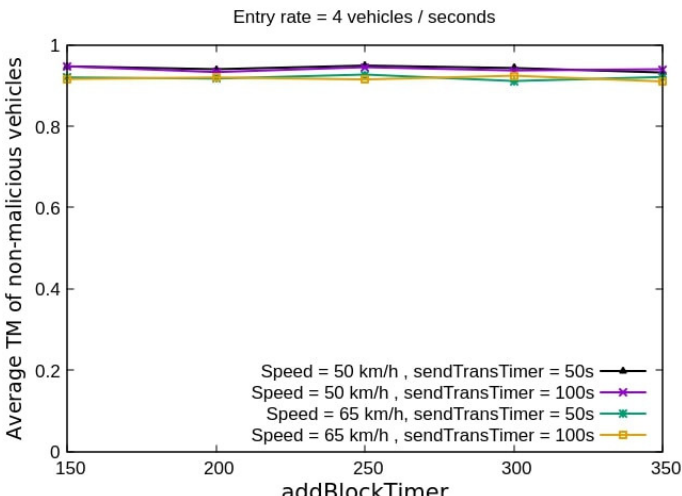
Figure 5. The average trust metric of non-malicious vehicles as a function of addBlockTimer(s), entry rate = 4 vehicles/s.